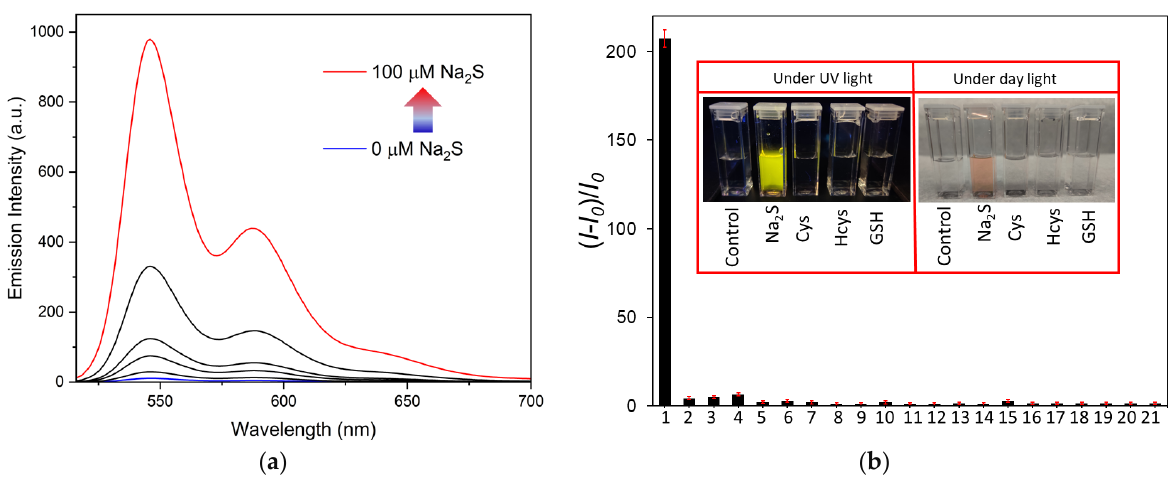
Figure 4. ( a ) Fluorescence turn-on response of APBI-Cu nanorods in presence of Na 2 S (from 0–100 μ M) in pure aqueous medium. ( b ) Relative fluorescence intensity change APBI-Cu nanorods toward various competitive analytes (100 μ M) (1) Na 2 S, (2) cysteine, (3) homocysteine, (4) glutathione, (5) NaF, (6) NaCl, (7) NaBr, (8) NaI, (9) NaNO 2 , (10) NaNO 3 , (11) NaHSO 3 , (12) Na 2 SO 3 , (13) Na 2 SO 4 , (14) NaHCO 3 , (15) Na 3 PO 4 , (16) ethanol, (17) hexanol, (18) phenol, (19) acetic acid, (20) butanoic acid and (21) hexanal Inset: naked eye visualization of the fluorometric and colorimetric change of APBI-Cu nanorods in the presence of Na 2 S and other thiol containing biomolecules.